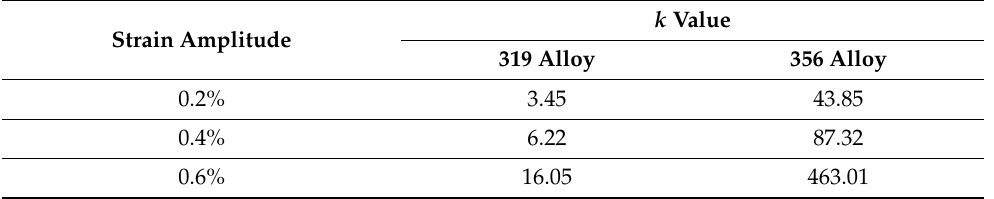
Table 6. Coarsening rate during TMF under various strain